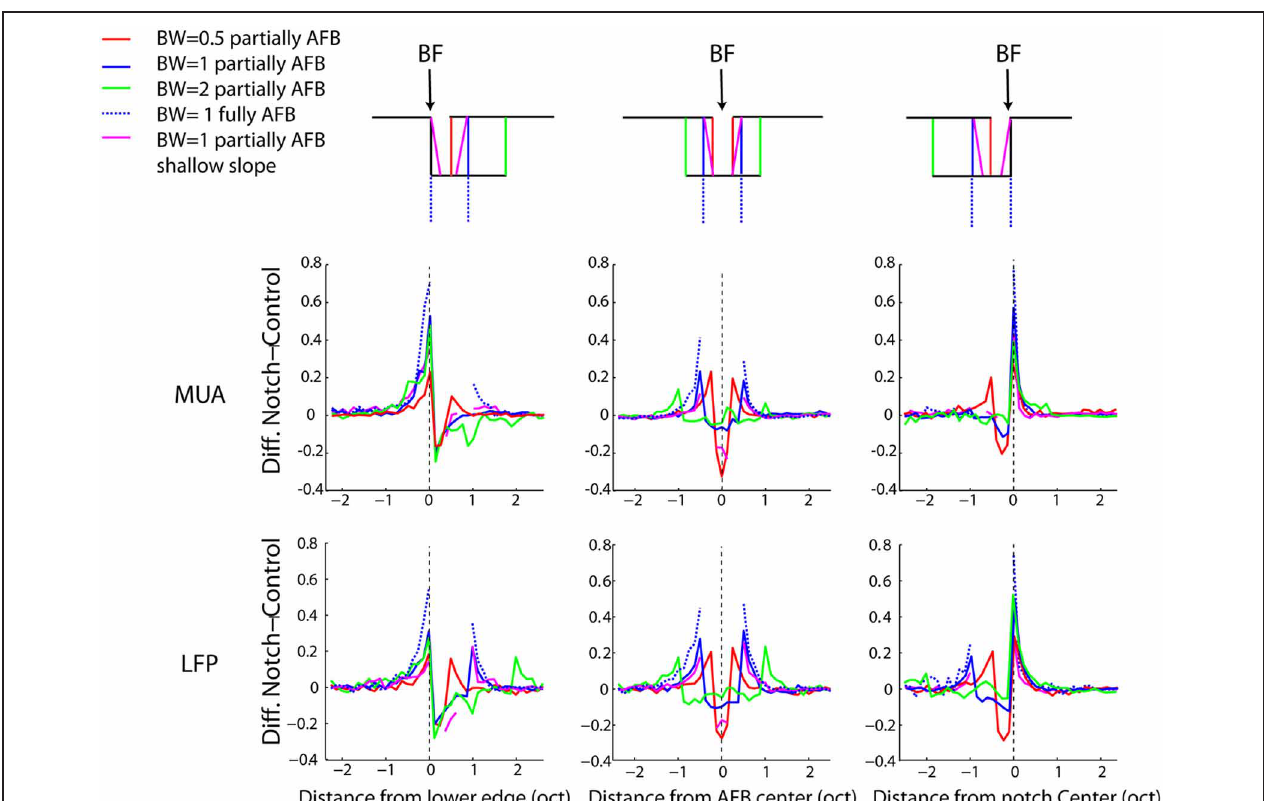
column: average data for neurons with BF corresponding to the AFB center. Third column: average data for neurons with BF corresponding to the upper edge of the AFB. Neural responses at both edges of the notch are largely enhanced, while they are reduced within the notch. The enhancement of neural responses was maximal for the fully AFB and minimal for the half-an-octave condition. The reduction of responses within the AFB was larger when the BF corresponded to the lower edge of the AFB (vs. upper